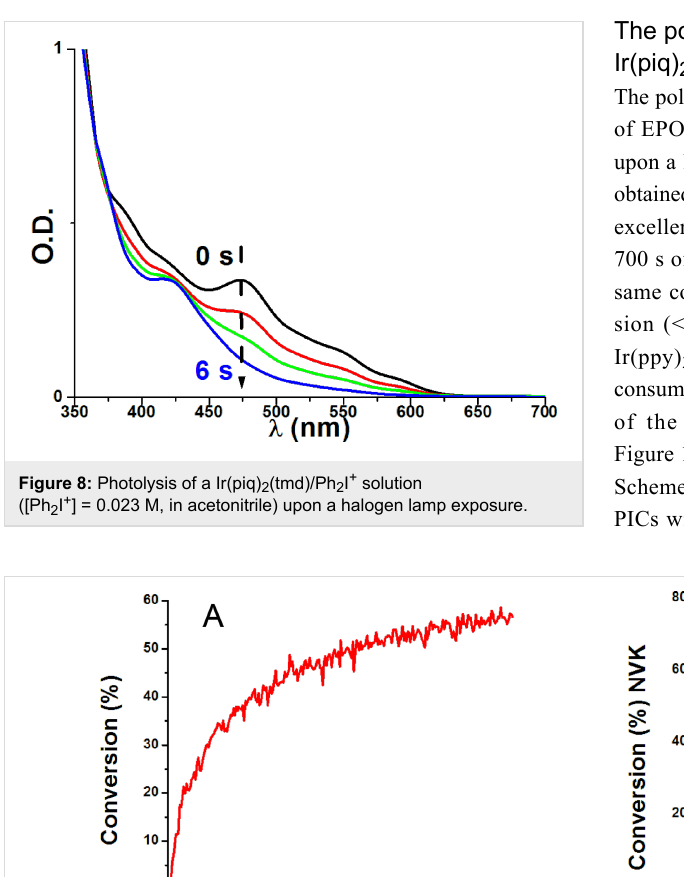
The polymerization initiating ability of the Ir(piq) 2 (tmd)/Ph 2 I + /NVK